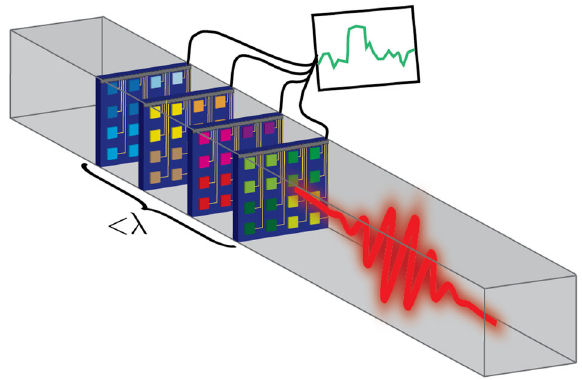
detector. A photon of wavelength λ is guided into a single mode waveguide.